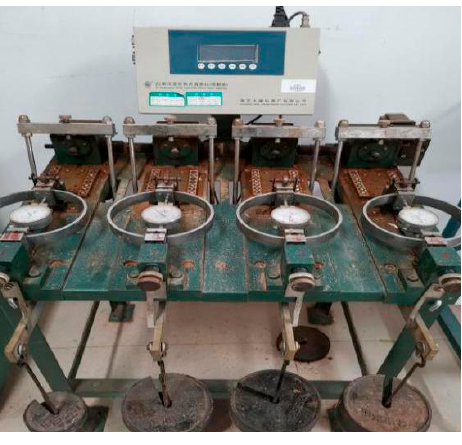
Figure 17. Direct shear test. Table 3. Comparison of basic parameters of soil before and after grouting.